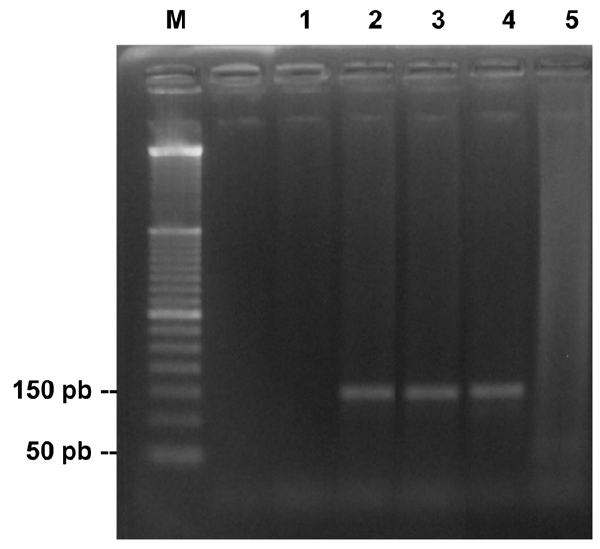
Figure 1. PCR assay revealing the target fragment of 144 pb in the DNA of P.lutzii . M, molecular marker of 50 bp; 1, negative control; 2, 3 and 4, DNA of P. lutzii isolates 01, ED01 and 1578, respectively; 5, human DNA.